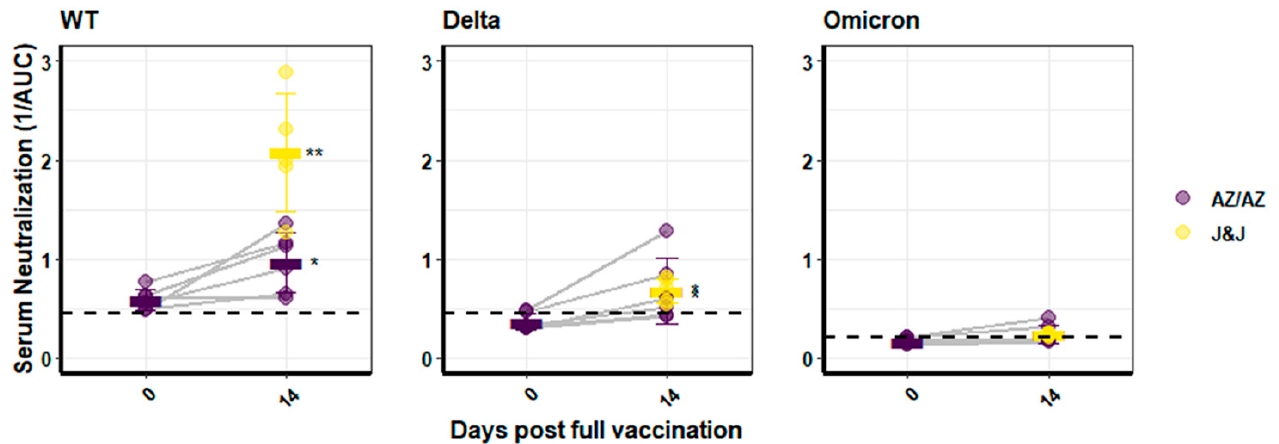
Figure 3. Neutralization activity of sera. Sera from AZ- or J&J-immunized individuals were analysed using lentiviral vectors pseudotyped with the WT, Delta, or Omicron spike. Neutralization is depicted as the reciprocal area under the curve. J&J vaccination was a single dose, and the values are depicted in yellow. For Omicron, no significance was assessed, as mean levels were below background values. Bars indicate the arithmetic mean for each group. Significance is indicated with two stars (**) for a p -value between 0.001 and 0.01, and one star (*) denotes a p -value between 0.01 and